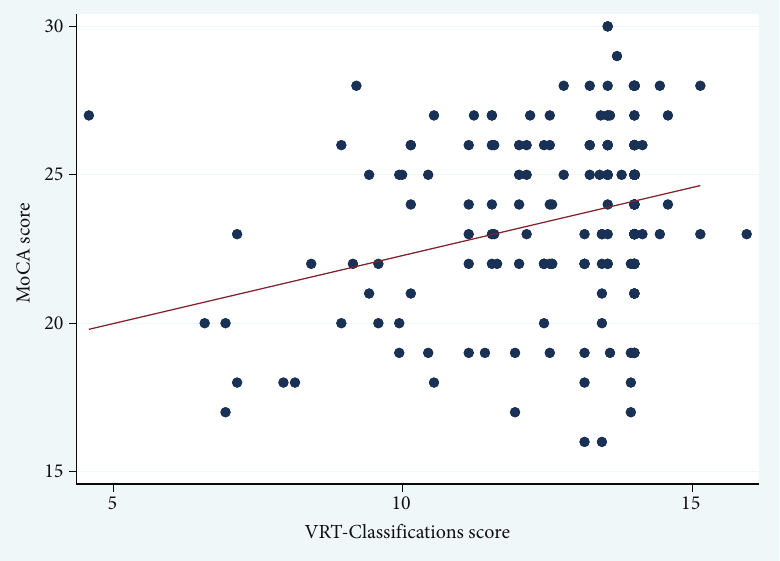
Figure 1: Pearson ’ s correlation between MoCA scores and VRT-classi fi cation in patients with Parkinson ’ s disease.